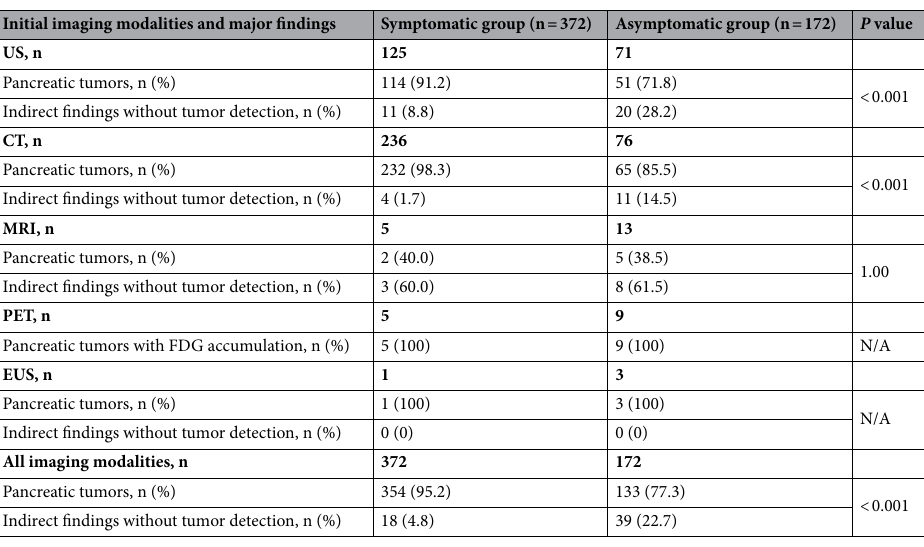
Table 5. Initial imaging modalities and major findings that led to further examinations. CT computed tomography, US ultrasonography, MRI magnetic resonance imaging, PET positron emission tomography, FDG fluorodeoxyglucose, EUS endoscopic ultrasonography, N/A not